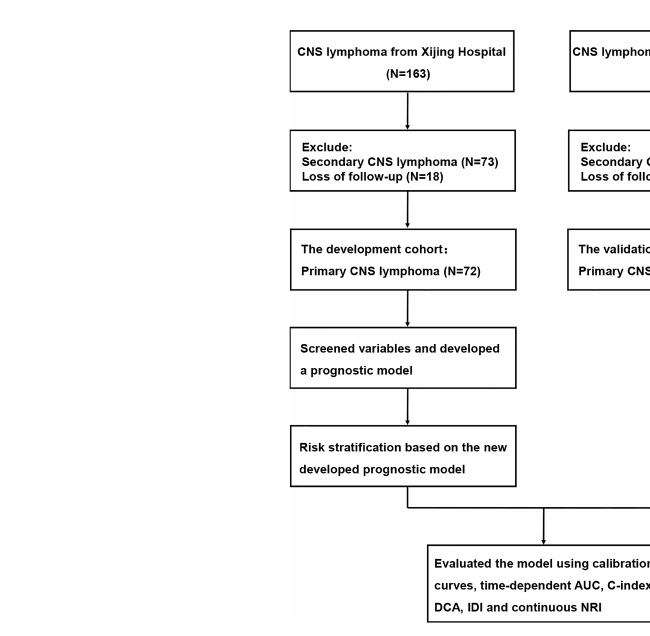
FIGURE 1 Flow chart of patient